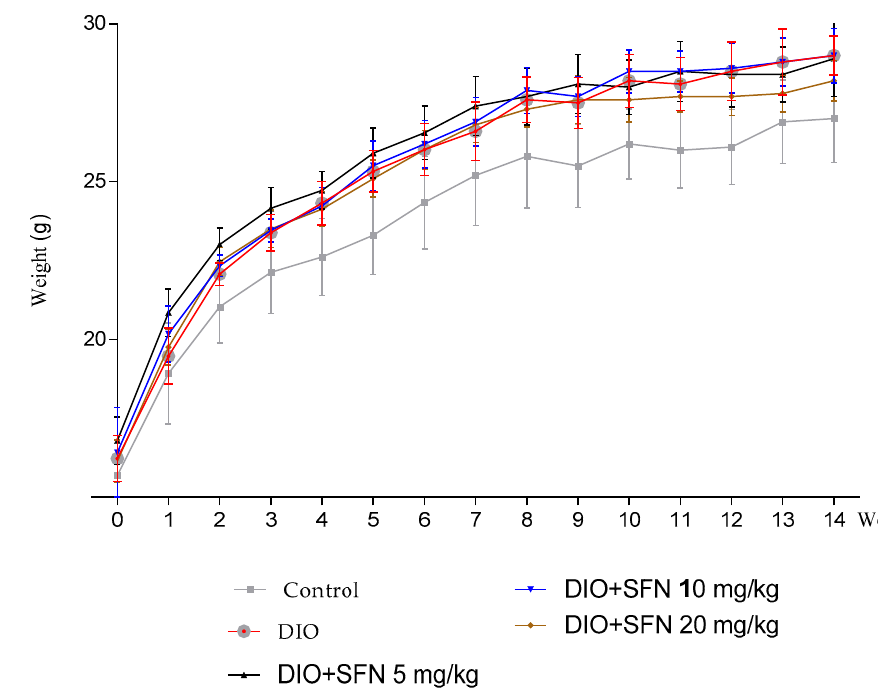
Figure 3. E ff ect of high-fat diet (HFD) on body weight changes in 14 Figure 3. Effect of high-fat diet (HFD) on body weight changes in 14 weeks.